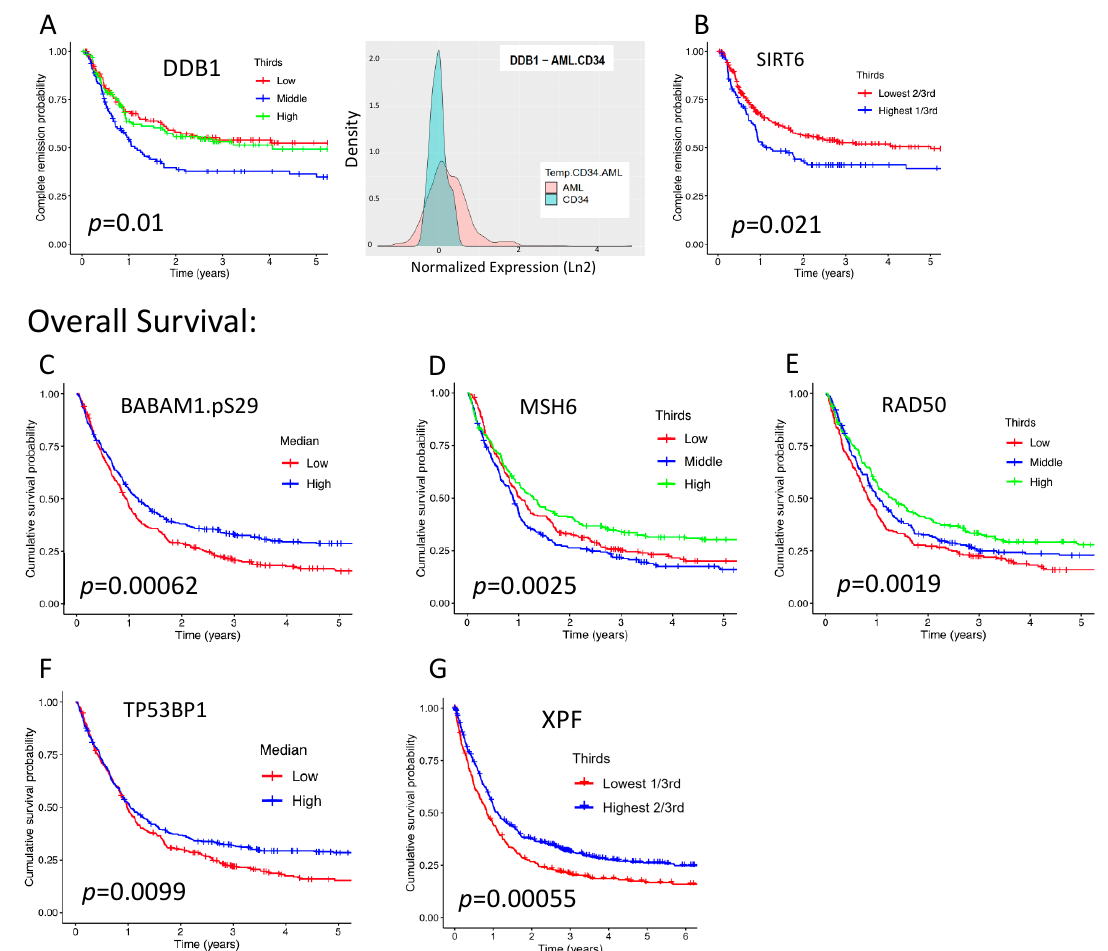
Figure 3. 7 DDR proteins are individually prognostic for remission duration and/or overall survival. Each of the 21 DDR proteins was analyzed at multiple expression level splits to determine if any were significantly associated with clinical outcomes. Of the 21, only 7 were individually prognostic, and only the most significant splits for each protein were chosen for display. RD curves ( n = 398) significantly stratified by ( A ) tercile of DDB1 expression and ( B ) lowest two-thirds and highest one- third of SIRT6 expression. The density graph insert to the right of ( A ) shows that AML cells display a much broader distribution of DDB1 expression than do normal CD34+ cells, whereby a significant proportion of AML cells are characterized by DDB1 overexpression. OS curves ( n = 684) stratified by ( C ) median of BABAM1.pS29 expression, ( D ) tercile of MSH6 expression, ( E ) tercile of RAD50 expression, ( F ) median of TP53BP1 expression, and ( G ) lowest one-third and highest two-thirds of XPF expression.